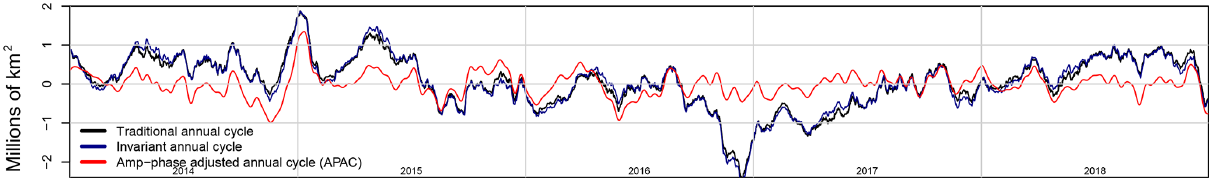
Figure 5. Comparison of anomalies from three annual cycle estimates for 2014–2018: the raw anomaly from the traditional annual cycle (black), the estimated anomaly from the invariant annual cycle (blue), and the estimated anomalies from the amplitude- and phase-adjusted annual cycle (red). The vertical axis is the anomaly in millions of square